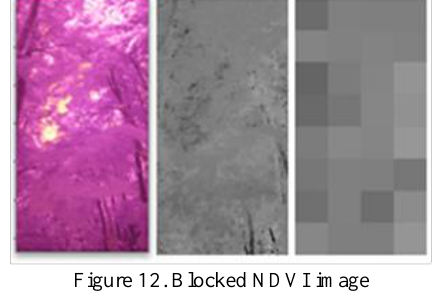
Figure 12. Blocked NDVI